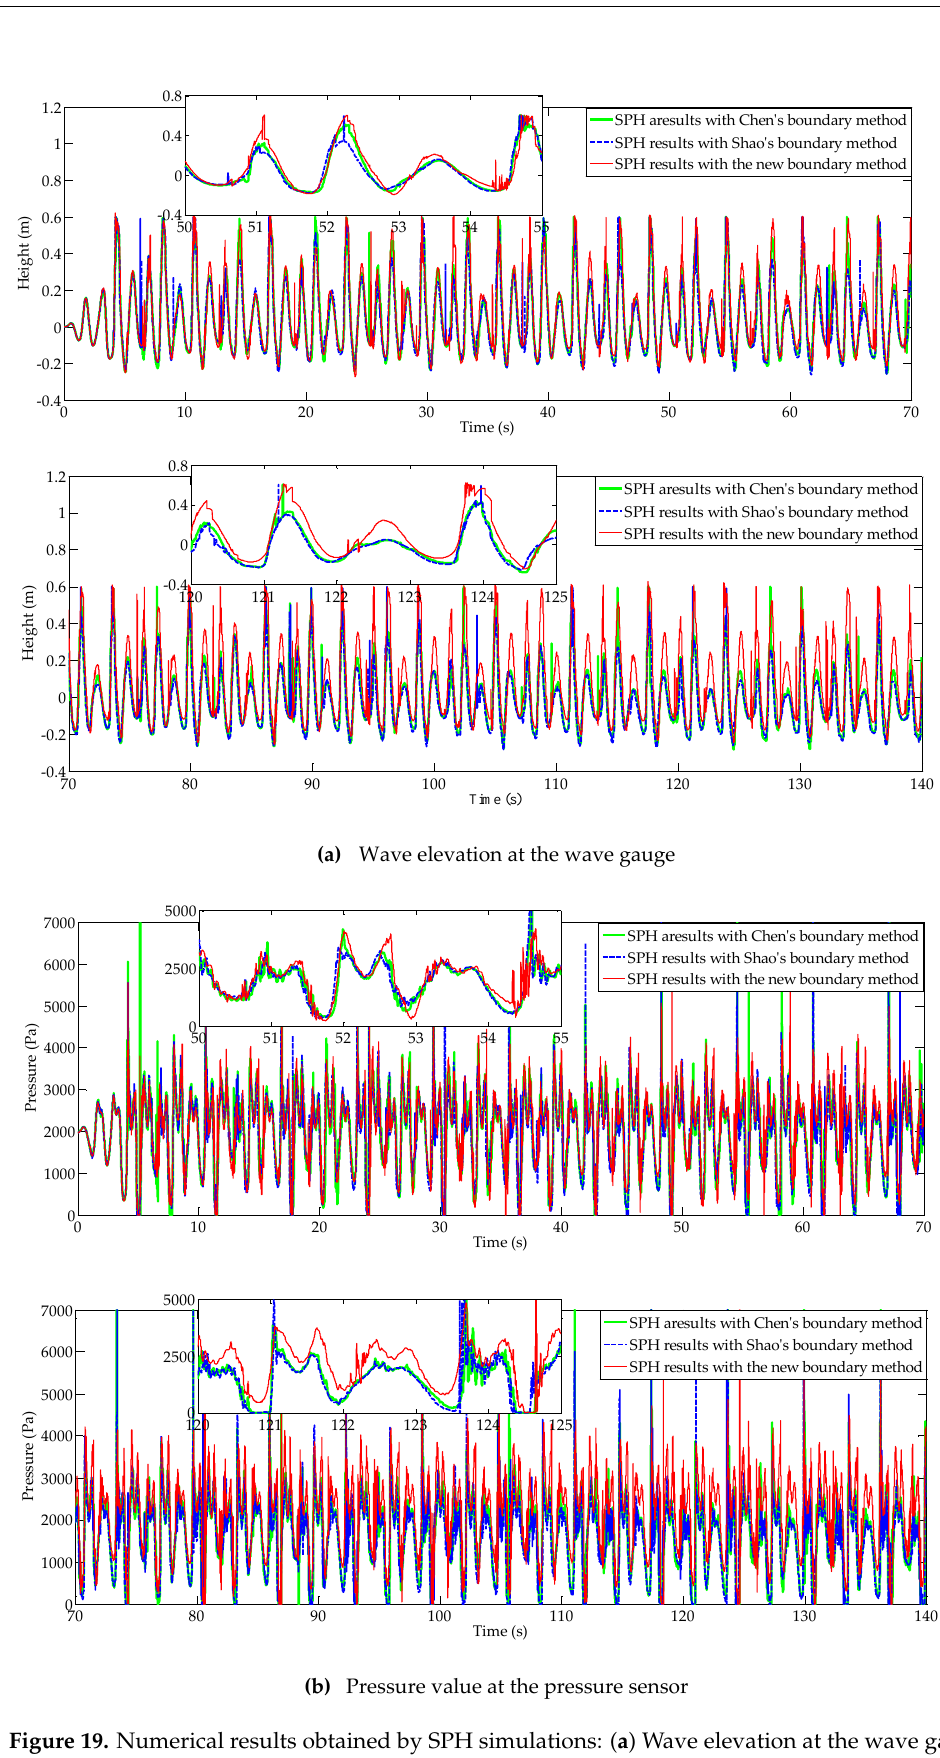
21 of 24 ( a ) Pressure distribution in FVM simu- lation ( b ) Flow pattern in FVM simulation ( c ) Flow pattern and pressure distribu- tion in SPH simulation Figure 18. Comparisons of the flow pattern and pressure distribution at 18.0 s: ( a ) Pressure distribution in FVM simulation; ( b ) Flow pattern in FVM simulation; ( c ) Flow pattern and pressure distribution in SPH simulation. To compare the new SBT algorithm with previous ones, the SPH simulations with different coupled dynamic SBT algorithms are conducted for 140 s. Although fluid parti- cles penetration also appears in the SPH simulation using the new SBT algorithm, the number of fluid particles penetrating the wall boundary is much smaller than those using the previous SBT algorithms, as shown in Table 3. A great improvement in the ability of preventing fluid particles penetration is observed. It should be noted that, at the initial state of the SPH simulation with  = 0.01m x , there are 3960 fluid particles in the fluid domain. Figure 19 shows the results of the liquid sloshing SPH simulations. Since the grid distortion in FVM simulation after 20 s is gradually becoming severe as the simulation goes, the FVM results are less accurate and not present in Figure 19. As the SPH simulation goes, more and more fluid particles penetrate the wall boundary and are removed from the computation domain in the SPH simulation using the previous SBT algorithms. The discrepancy between the SPH results with the new SBT algorithm and the previous SBT algorithms is becoming more and more obvious along with the increase of the number of penetration fluid particles, as shown in Figure 19.